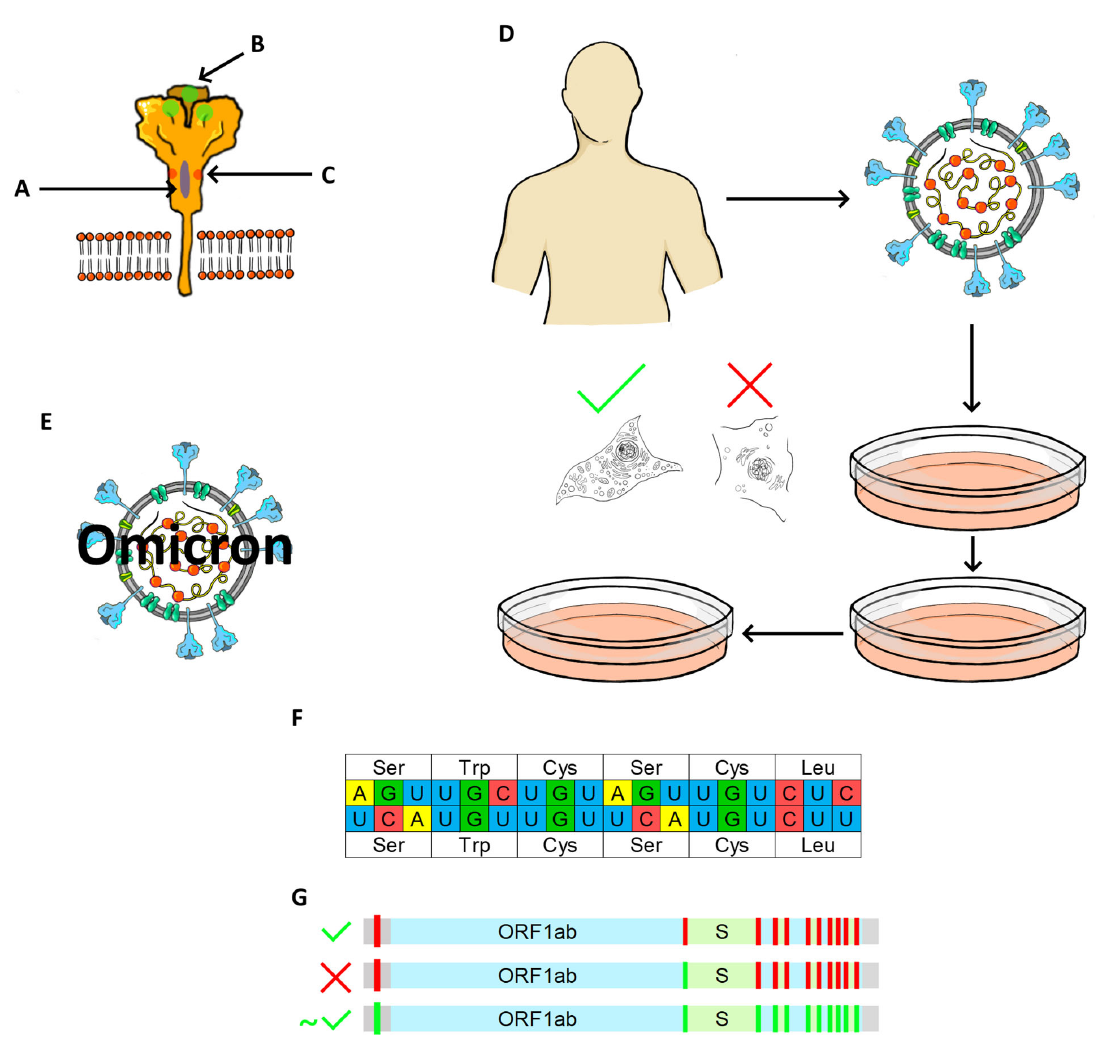
Figure 3. Attenuation strategies applicable to SARS-CoV-2 (Part 2). ( A ) Spike protein Heptad Repeat 1 disruption. ( B ) Spike T345I mutation. ( C ) Furin cleavage site disruption. ( D ) Naturally-occurring, persistently replicating SARS-CoV-2 isolate. ( E ) SARS-CoV-2 Omicron variant. ( F ) Codon pair deoptimization; a fragment derived from parental virus (top) and one of the attenuated viruses (bottom) are presented; the exchange of synonymous codons within a genome fragment is not shown. ( G ) TRS core replacements.